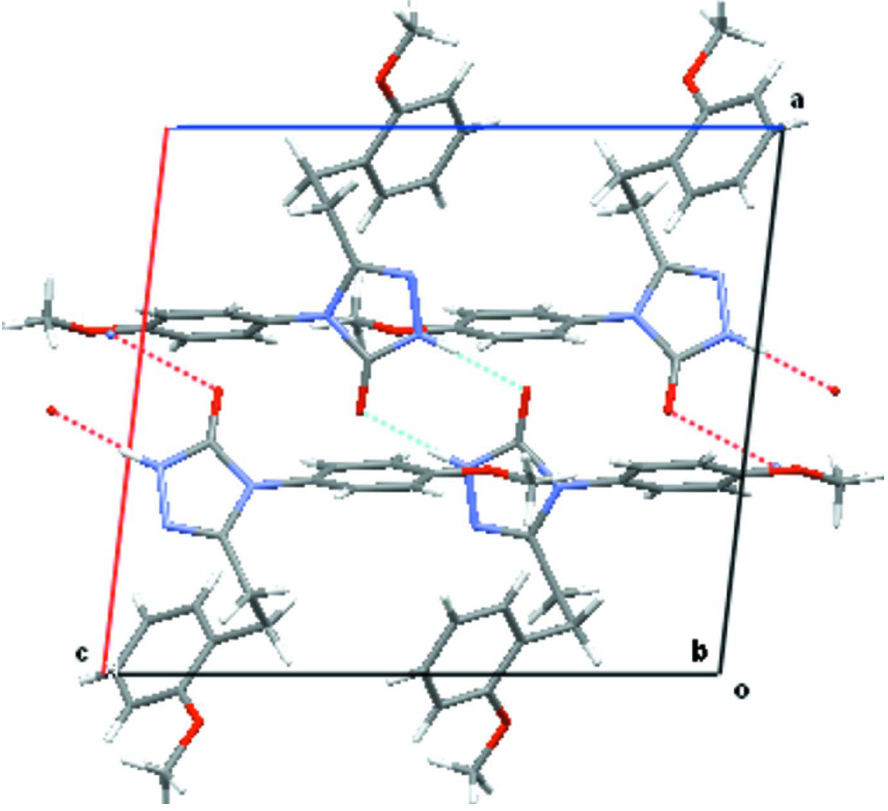
Figure 1 The molecular structure of the title compound with 50% probability displacement ellipsoids (arbitrary spheres for H